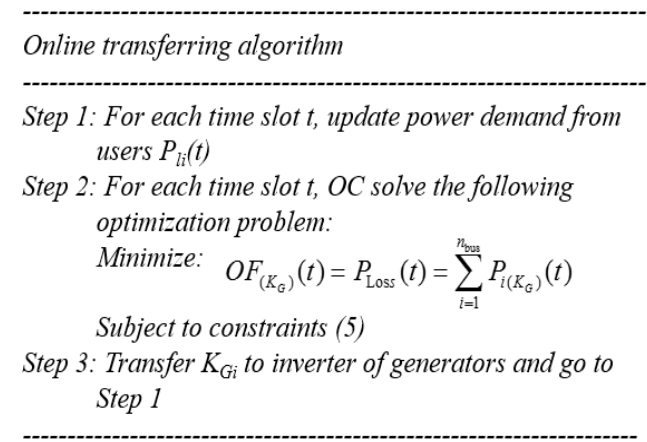
Figure 3. Pseudocode of online optimization process. Energies 2020 , 13 , x FOR PEER REVIEW